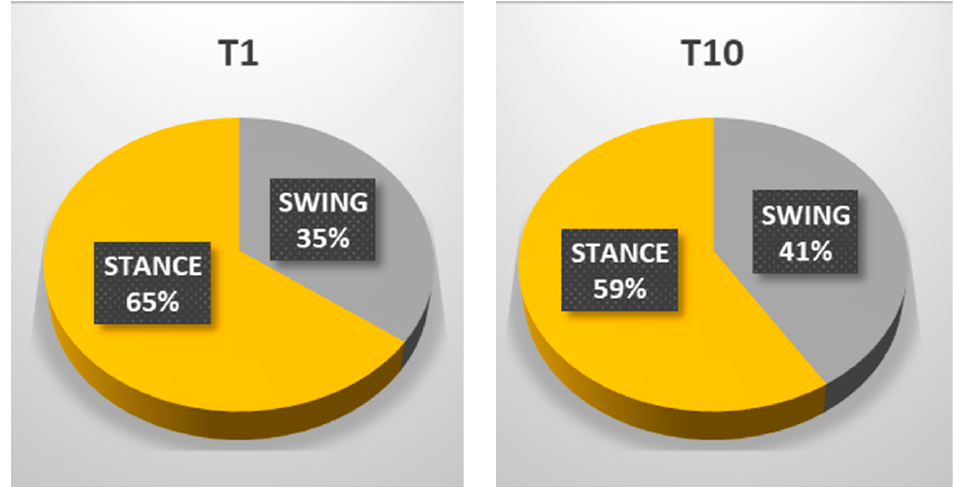
Figure 3. Differences in step percentages between initial ( T1 ) and final evaluation ( T10 ); as shown, initially the patient had a general prevalence of stance (65% of gait cycle). After RAGT and physiotherapy the stance was reduced to 59%, and swing phase was increased to 41%. These values are close to referred healthy subject ones (60% stance, 40% swing, Parry).